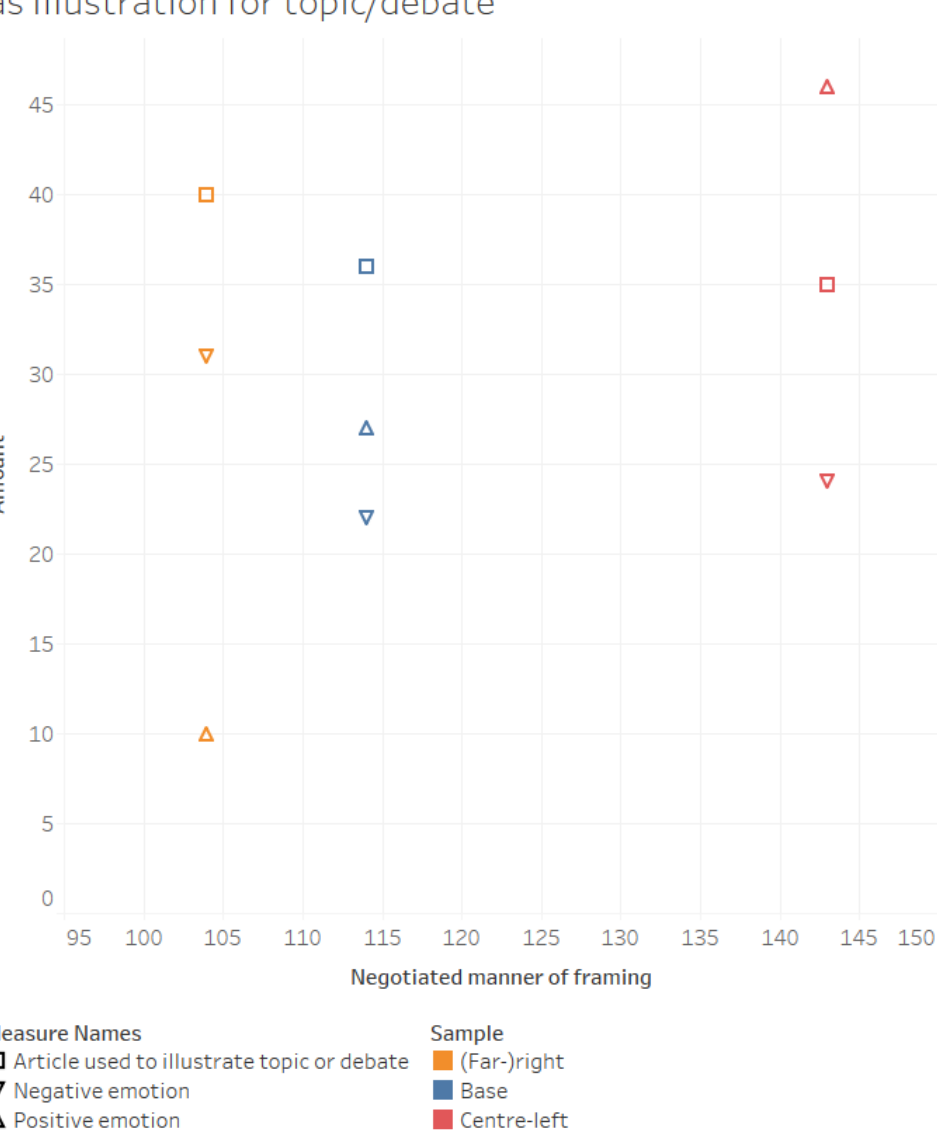
Fig. 5. Negotiation scatterplot: emotion and usage of message as illustration for